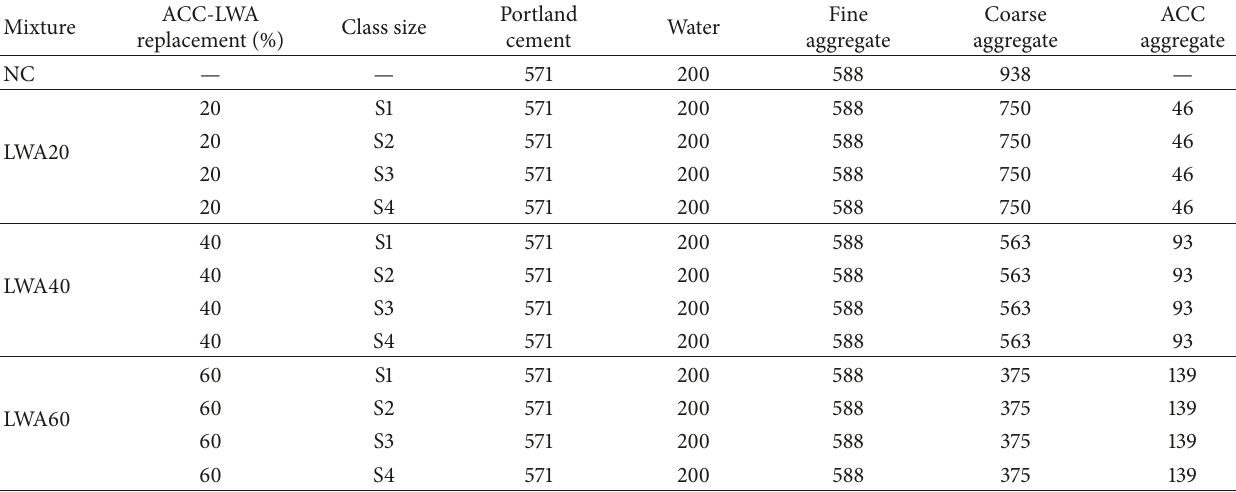
Table 3: Details of mixture designation (kg/m 3